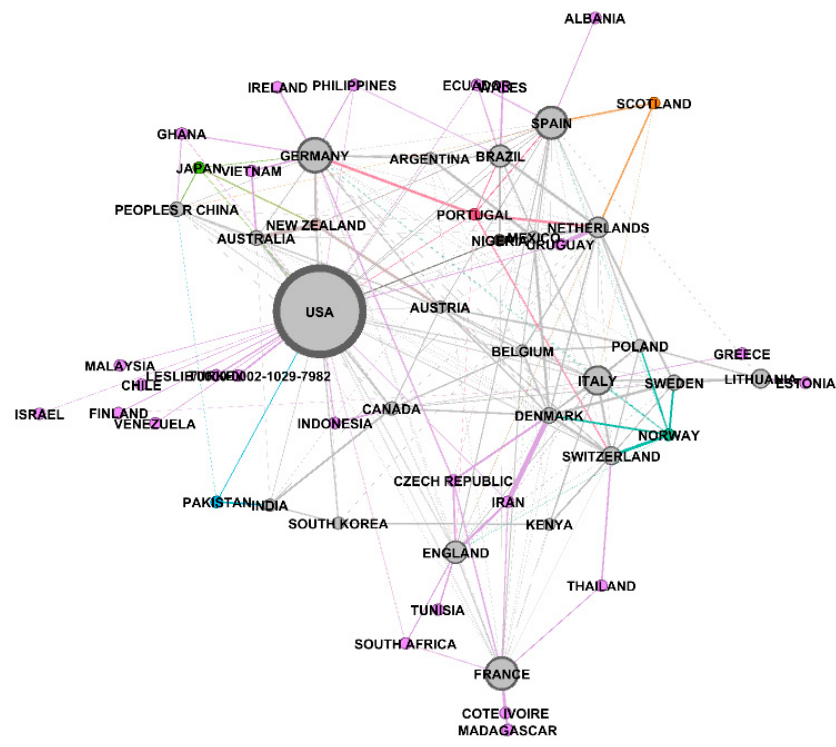
Figure 9. The results of country cooperation network Figure 9. the results of country cooperation network analysis. Figure 9. the results of country cooperation network analysis.